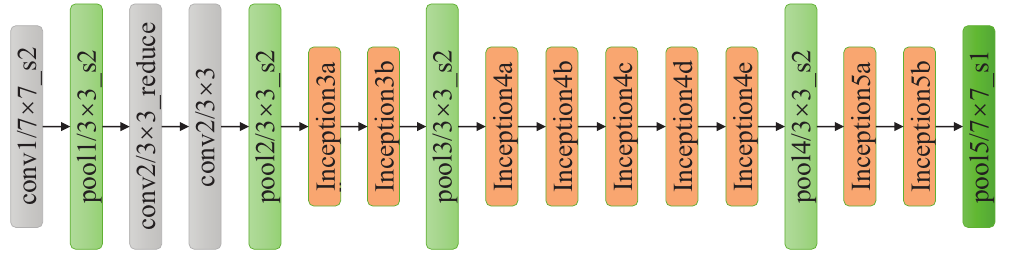
Figure 6. The architecture of Inception module.